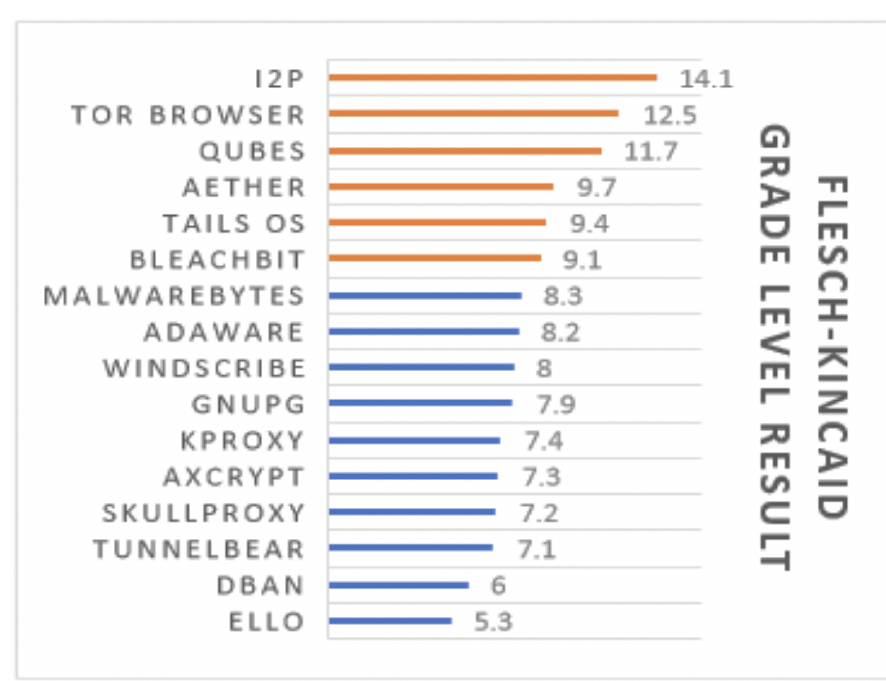
Figure 5. Flesch–Kincaid Grade Level test